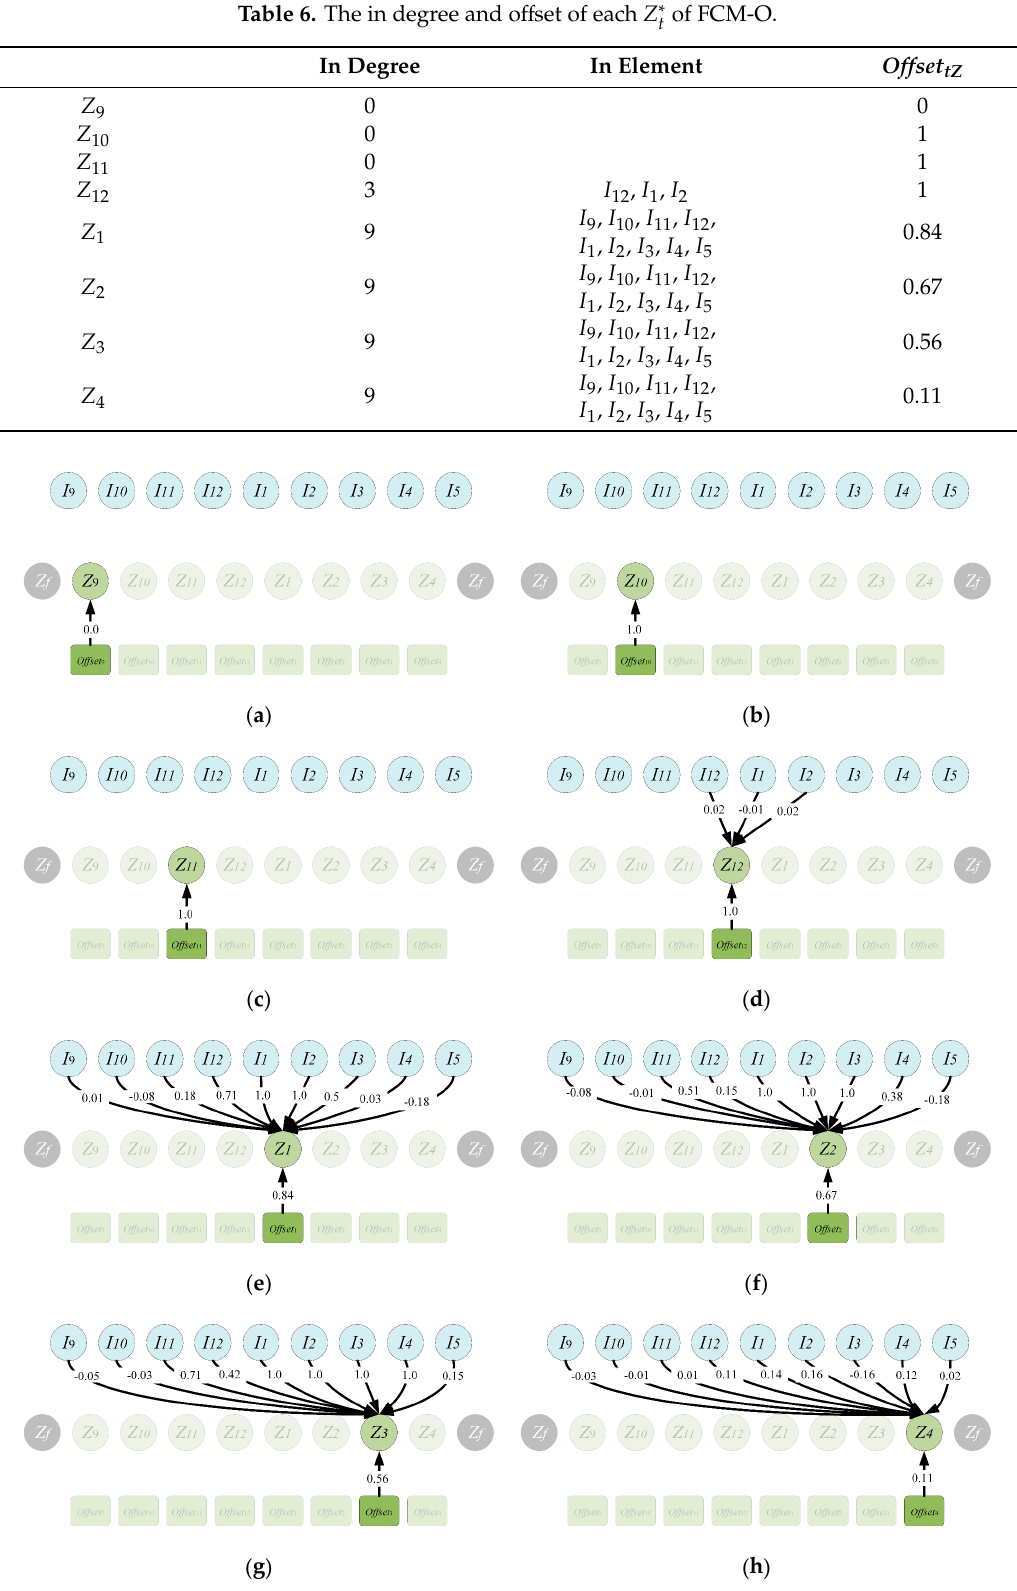
* Z I t } and { t } obtain by FCM-O. ( a )